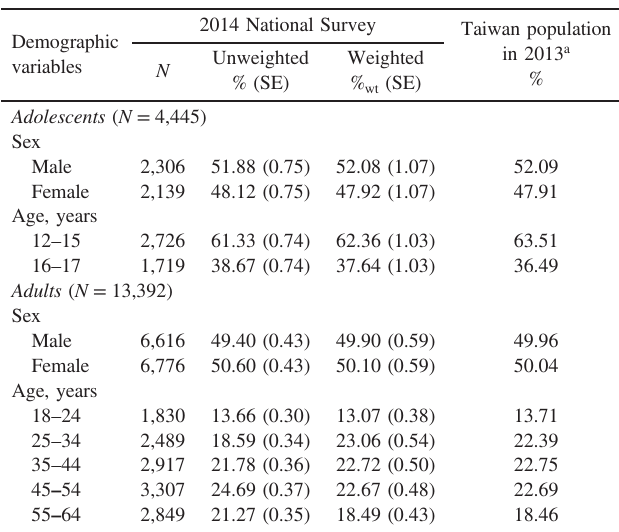
Table 1. Demographic characteristics of adolescent (12 – 17 years) adult (18 – 64 years) participants in 2014 National Survey on Substance Use as compared to that of the general population in Taiwan Demographic variables